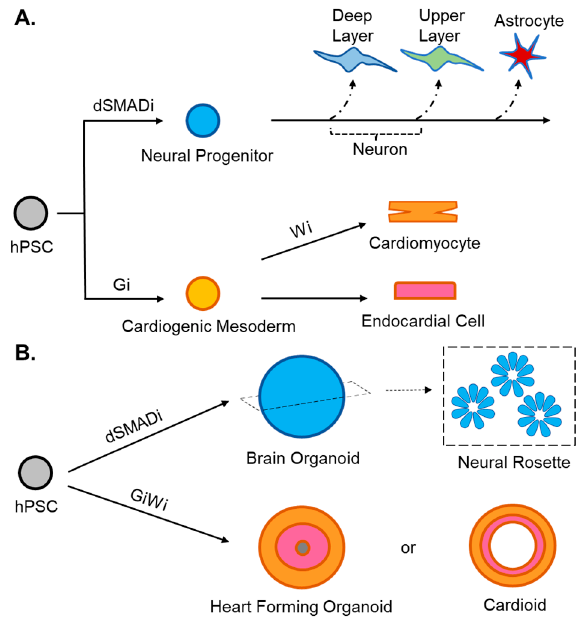
Figure 2. Diagrams providing overview of 2D and 3D differentiation methods. ( A ). Overview of 2D differentiation towards cortical neural progenitors and cardiogenic mesoderm. Neural progenitors can be generated using the dual SMAD inhibition (“dSMADi”) protocol with high efficiency. Cardiogenic mesoderm cells are efficiently derived by activating Wnt signaling (e.g., GSK-3 β Inhibitor CHIR-99021, termed “Gi”). They can be further differentiated towards cardiomyocytes by inhibiting Wnt signaling (“Wi”), or towards endocardial cells. ( B ). Small molecules methods used in 2D differentiation can also be incorporated into 3D differentiation methods. However, levels and duration of factors will likely need to be